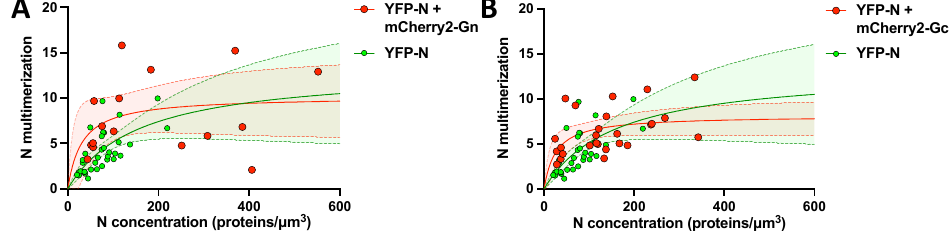
Figure 6. YFP-N forms high-order multimers in presence and absence of Gc and Gn. YFP-N multimerization as a function of total protein concentration (in monomer units) in the absence and presence of ( A ) mCherry2-Gn or ( B ) mCherry2-Gc expressed in CHO-K1 cells. Each point in the graph represents the average NP multimerization and concentration within a ROI in one CHO-K1 cell. Solid lines show non-linear fits to a binding kinetic model (Y = Bmax × X/(Kd + X)) and dashed lines indicate 95% confidence intervals. The fits are of relatively low statistical significance and should be viewed as a qualitative guide to the